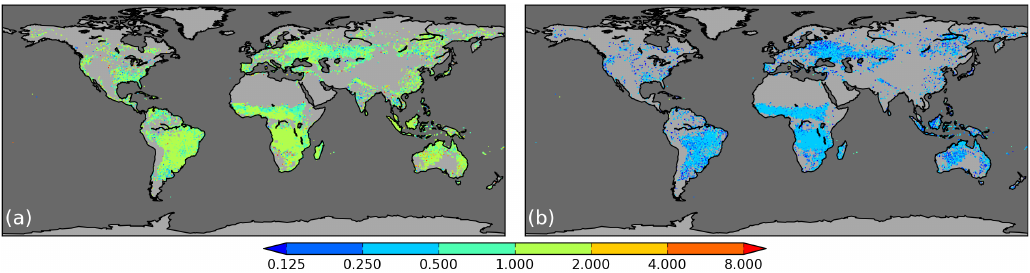
Figure 9. The ratio of fire-emitted AOT values at 550nm wavelength ( τ f Fig. 9. The ratio of fire-emitted AOT values at 550 nm wavelength ( 𝝉 on a 0.5 × 0.5 ◦ global grid. The changes in τ f (b) algorithmic new (FEER.v1) and old (IK05) products mapped on a 0.5 × 0.5° global grid. The changes 1547 𝒇 are due only to: (a) upgrading the data source from Collection 4 to Collection 5, 1548 in 𝝉 𝒂𝟓𝟓𝟎 and (b) algorithmic changes. 1549